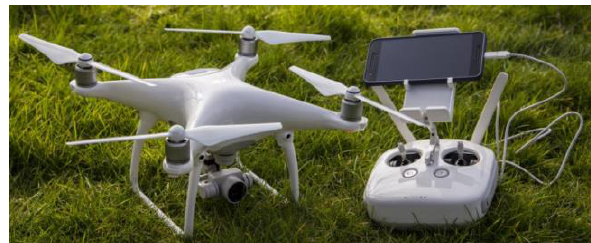
Figure 21. UAV-Photogrammetric Drone System – Phantom 4 DJI System